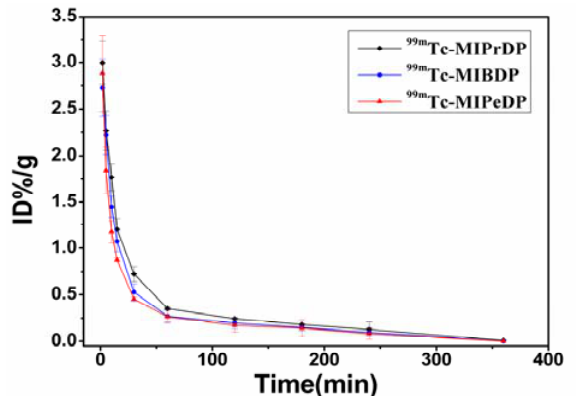
Figure 3. Pharmacokinetic curves in the mice for 99m Tc-MIPrDP, 99m Tc-MIBDP and 99m Tc-MIPeDP (n = 5, mean ±